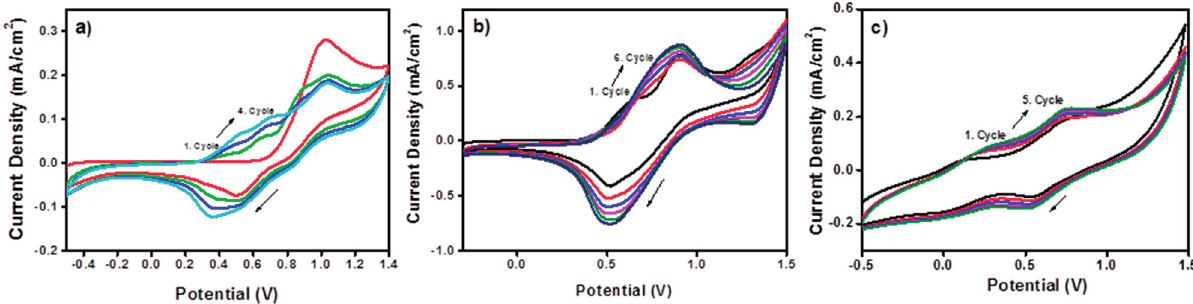
Figure 2. Cyclic voltammograms of ( a ) (SNS-NH 2 ) and ( b ) (SNS-NH 2 -Fc) and ( c ) (SNS-NH 2 )/(SNS-NH 2 -Fc) (1:4; w/w) in ACN/TBAPF solvent-electrolyte system at a scan rate of 0.25 V/s on